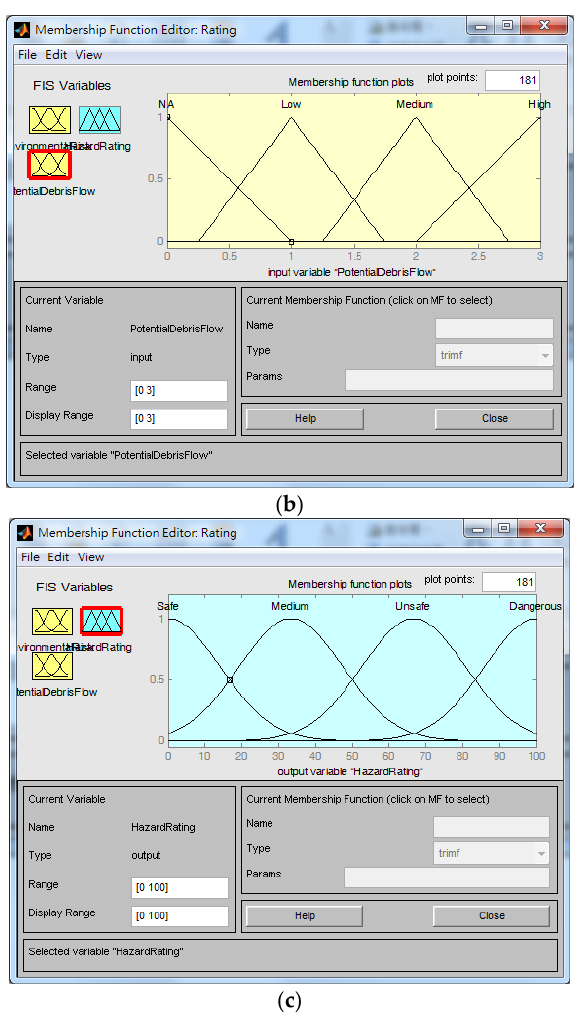
Figure 4. Fuzzy condition setting of input and output parameters. ( a ) Environmental risk; ( b ) potential debris flow; ( c ) hazard rating. Water 2016 , 8 , 54 Table 6. Logic rules of fuzzy expert system.